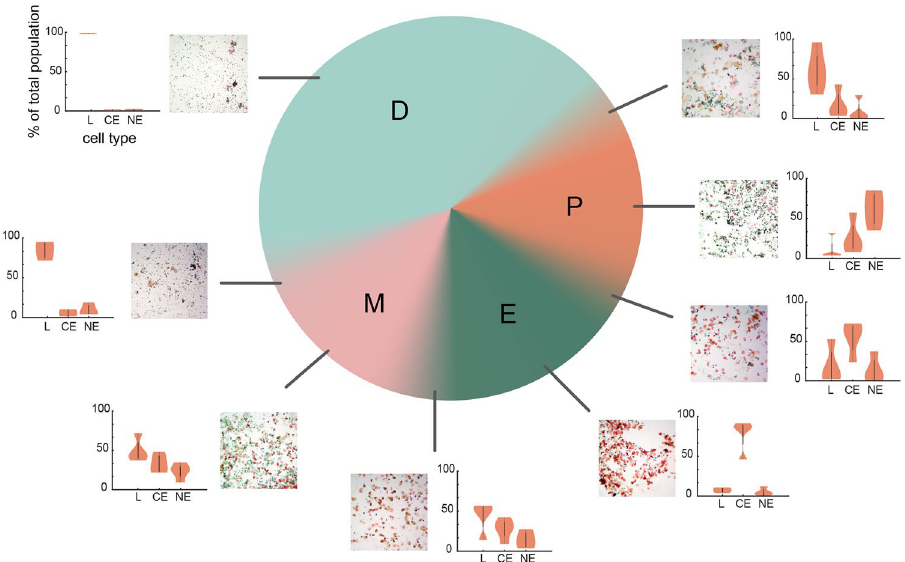
Figure 5. Characterization of cell types across the estrous cycle. A pie chart of the four estrous stages broken down by stage length across the 4–5-day cycle. Transition states between the four classical estrous stages are shown in gradient, and cytology collected from between the stages are included. Raw images and violin plots of cell counts from 8 primary and transition stages are shown (four examiners). The violin plots indicate the proportions of leukocytes (L), cornified epithelial (CE), and nucleated epithelial cells (NE), respectively (mean + / −